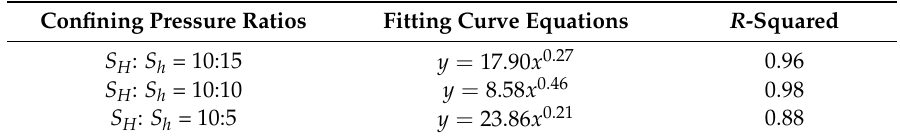
Figure 24. Variation of total number of cracks with NF density under different confining pressure ratios and injection rate is 2.0 × 10 − 6 m 3 /s. Table 6. Fitting curve equations of total number of cracks under different confining pressure ratios. Confining Pressure Ratios Fitting Curve